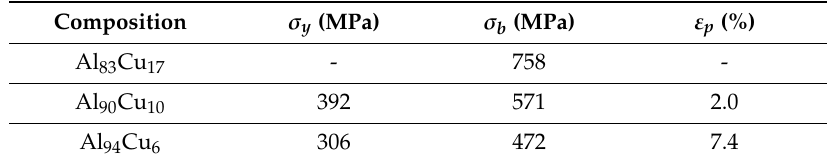
Table 2. Hardness (H) and elastic modulus (E) of di ff erent structures in alloys, measured by